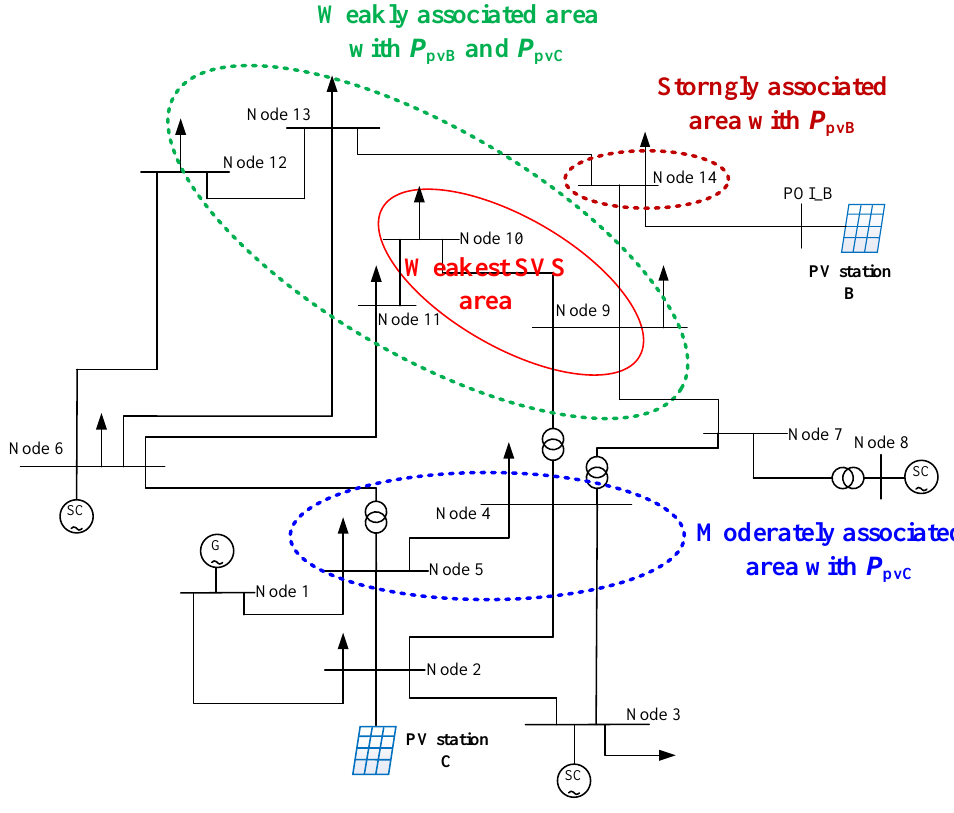
Figure 9. Static voltage stability zoning chart of Plan C.